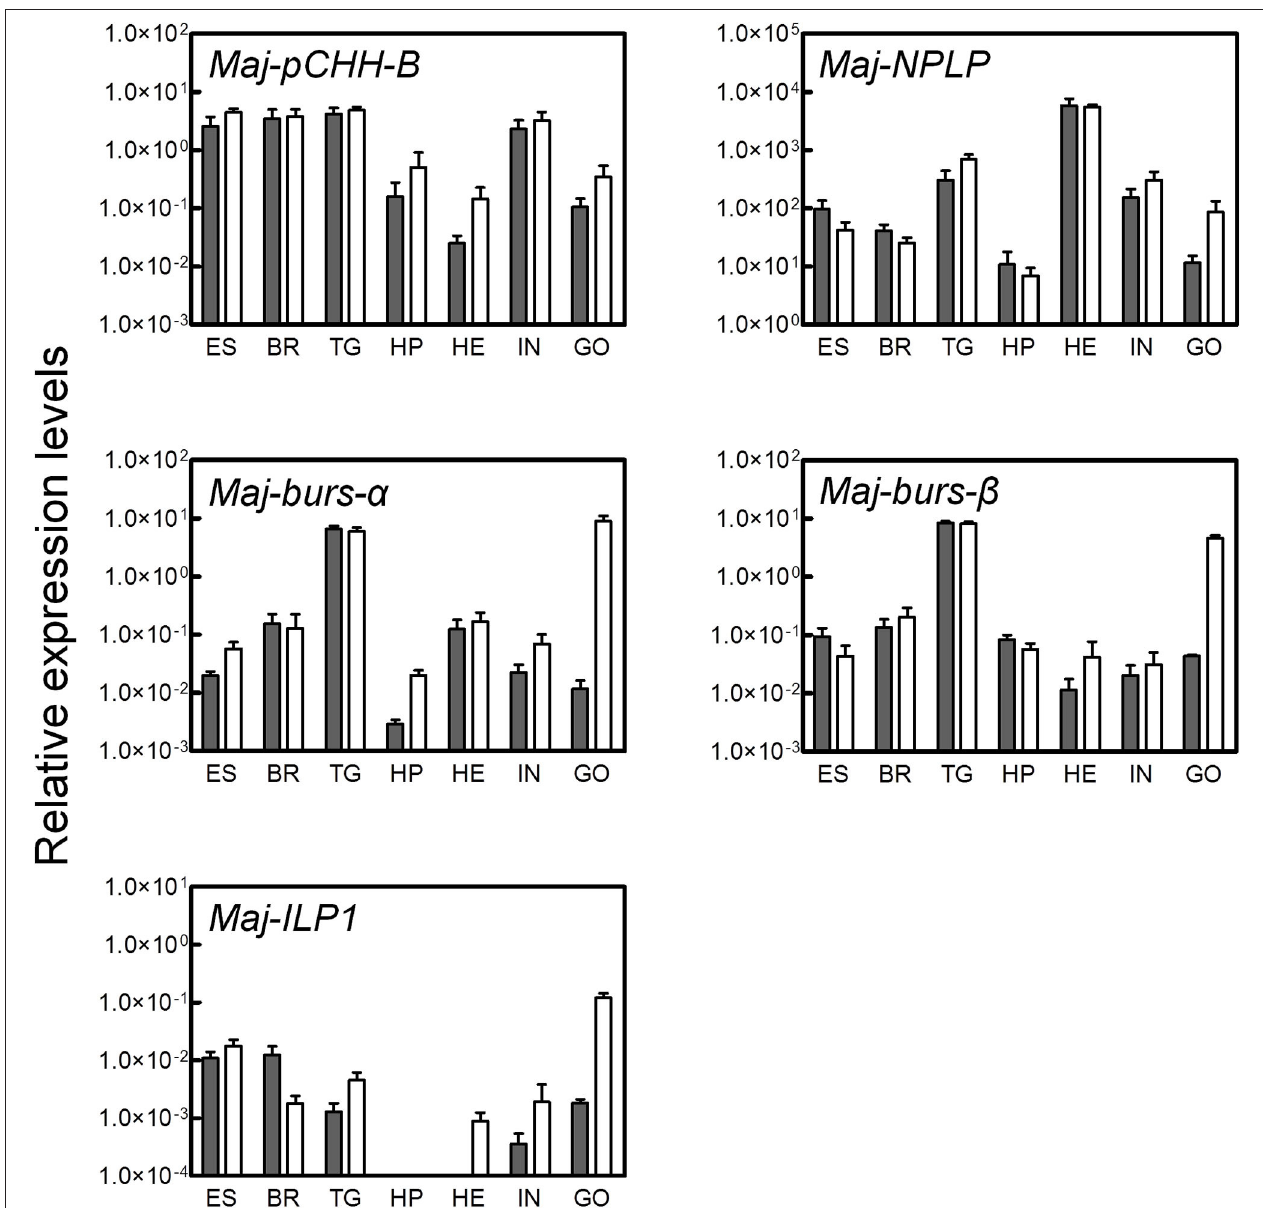
FIGURE 4 | Tissue-specific expression analysis of the putative hormones. Gene expression of the putative hormones were examined by qRT-PCR in various tissues (ES, eyestalk; BR, brain; TG, thoracic ganglia; HP, hepatopancreas; HE, heart; IN, intestine; GO, gonad). Relative expression levels per 8 ng of the total RNA have been represented as mean ± SEM ( n = 3). Open and solid bars represent female and male prawns,